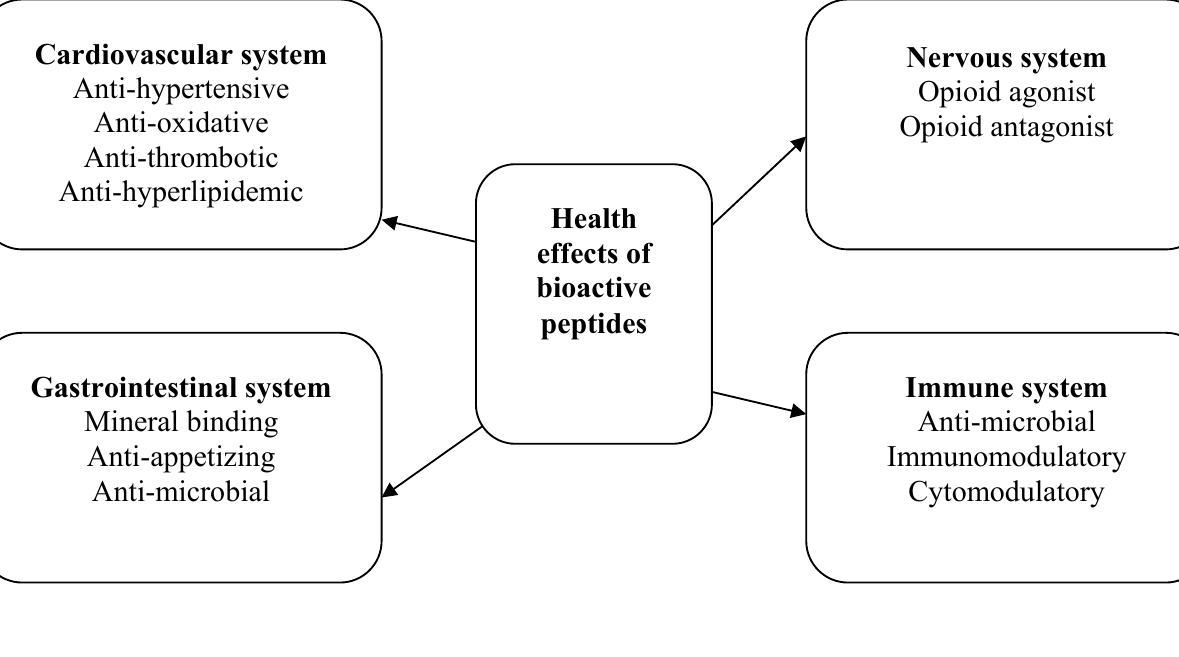
Figure 1. Physiological effects of food derived bioactive proteins on major body